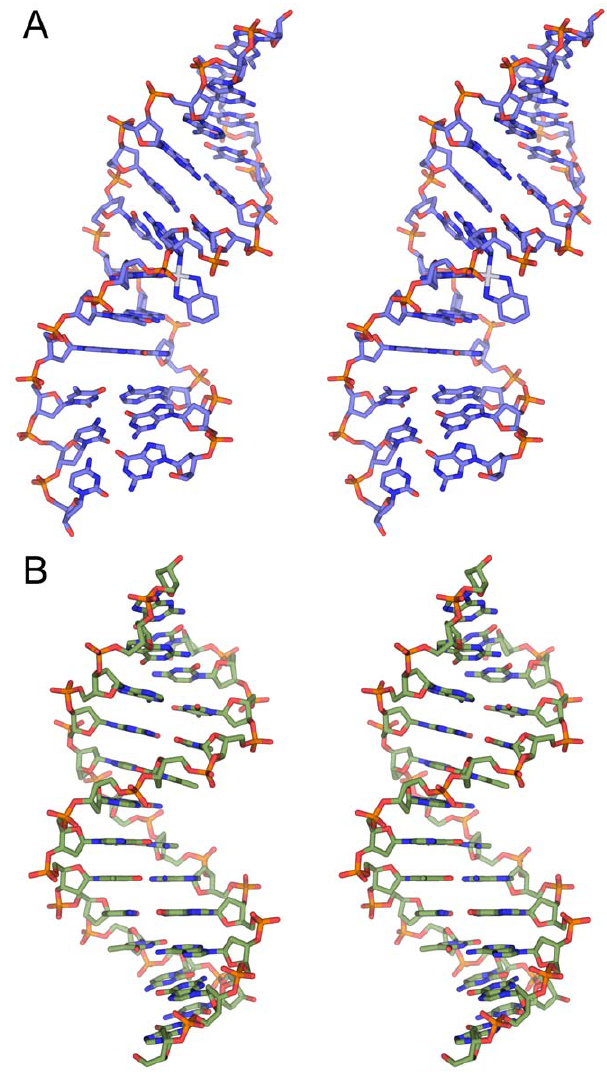
Figure 3. Based on the RMSD values, sequence context (TGGT versus AGGC) has no major effect on the overall conformation of either undamaged DNA or OX-GG DNA adducts.